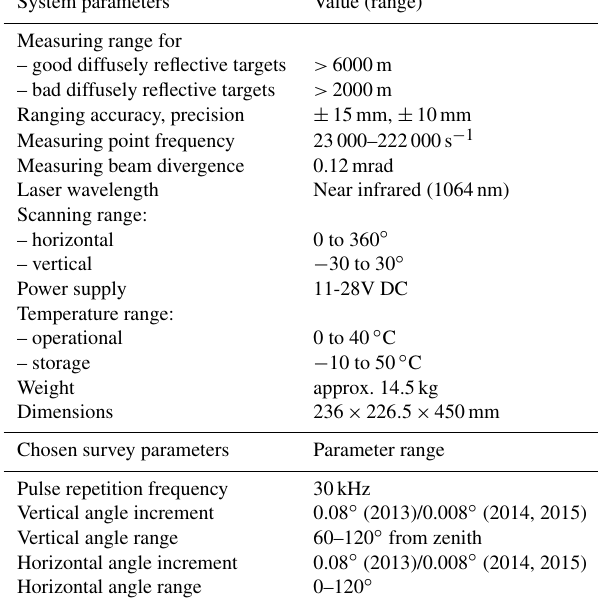
Table 2. Parameters and values of the Riegl VZ ® -6000 terrestrial laser scanner used for this study (RIEGL Laser Measurement Sys- tems, 2013), and typical survey parameters chosen for the individual annual field